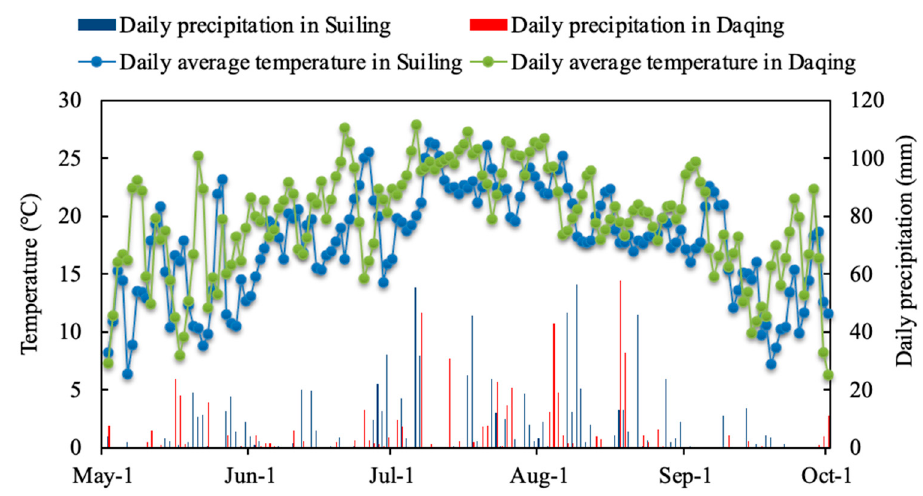
Figure 1. Daily average temperature and precipitation during the rice-growth season in Daqing (46°40 ′ N, 125°07 ′ E) and Suiling (46°40 ′ N, 125°07 ′ E).